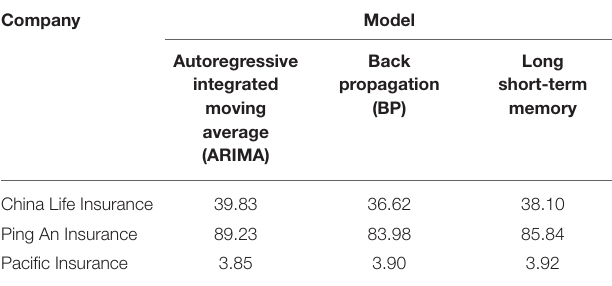
TABLE 5 | Predicted stock closing prices on January 4, 2021. Company